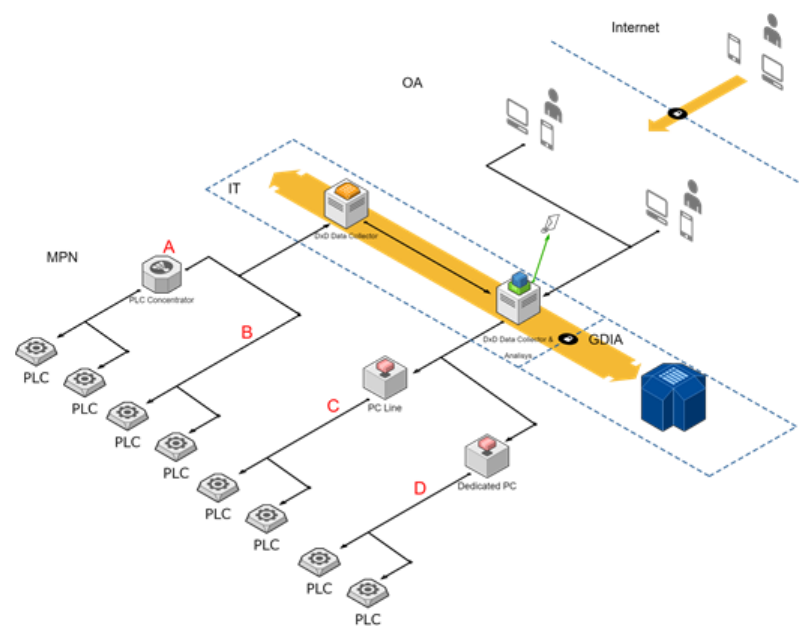
Figure 5. Architecture for miniterm 4.0. It collects mini-terms in real-time at Ford factories.